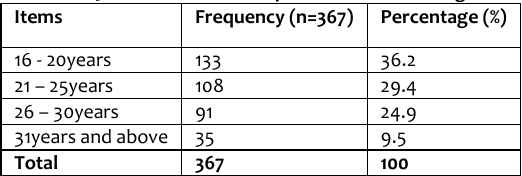
Table 3: Distribution of Respondents Based on